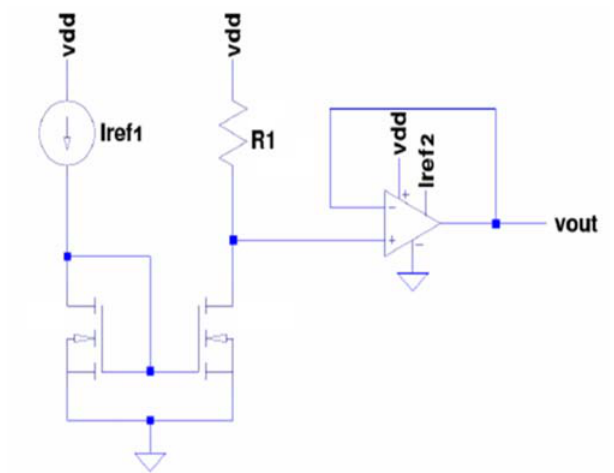
Figure 7. Schematic of the amplifier. Vdd: 5V, current reference 1 (Iref1): 2  A, current reference 2 (Iref2): 10  A, R1: SWCNT resistance; Vout: output